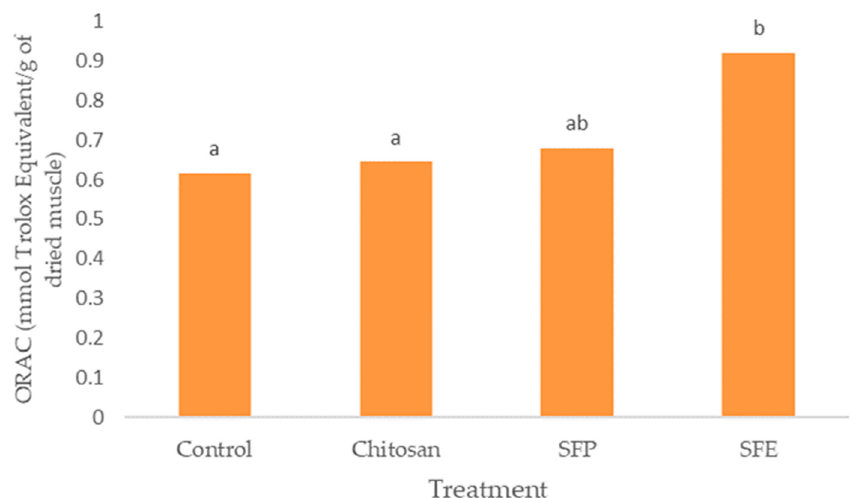
Figure 5. Effect of edible films on oxygen radical absorbance capacity (ORAC) in Atlantic horse mackerel coated with different film formulations (control without coating film, chitosan, sea fennel plant (SFP) incorporated in a chitosan-based film and sea fennel extract (SFE) incorporated in a chitosan-based film) and stored at 4 °C for 12 days. Different lowercase letters indicate significant differences ( p < 0.05) due to the treatment.